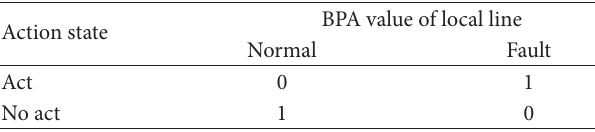
Table 1: BPA assignment of primary protection and direction comparison protection.